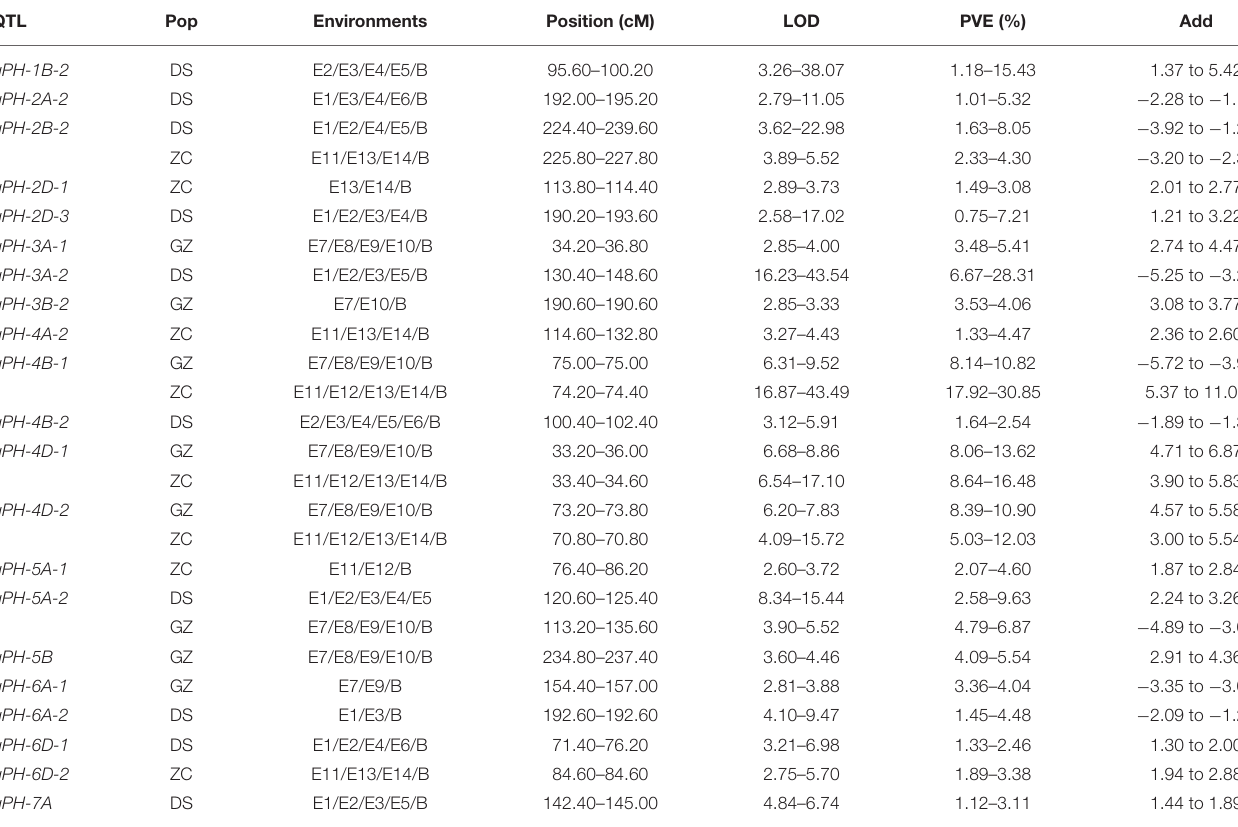
TABLE 3 | Stable quantitative trait loci (QTLs) identified for PH in the three RIL populations, DS, GZ, and ZC using the consensus